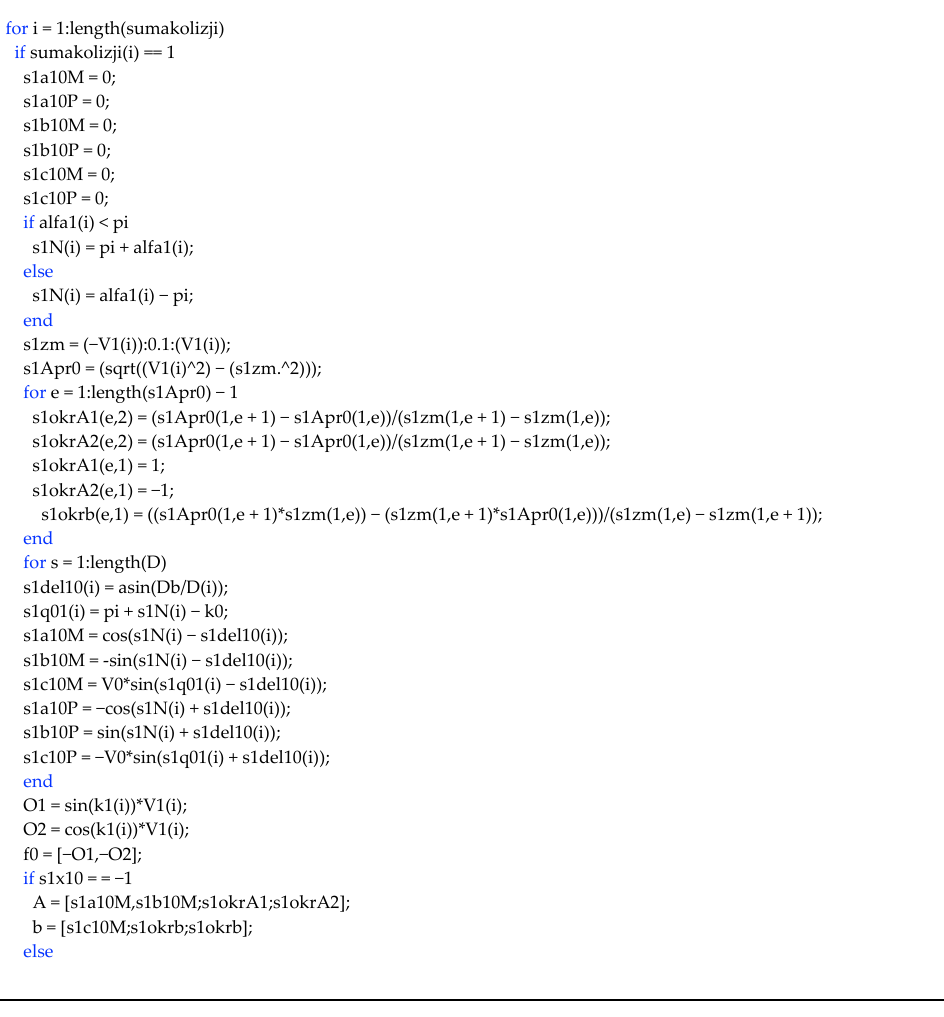
Algorithm A1 . Calculating optimal